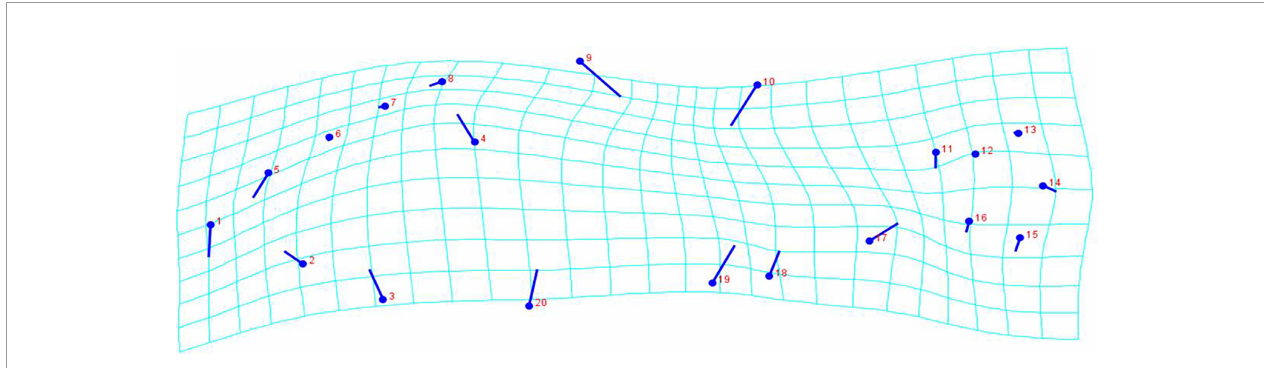
FIGURE 5 | Deformation grid plots and visualization of body shape variation between hatchery-reared and wild marbled rock fi sh. The vectors showing shape variation along the discriminant axis. Points relate to landmarks in Figure 1